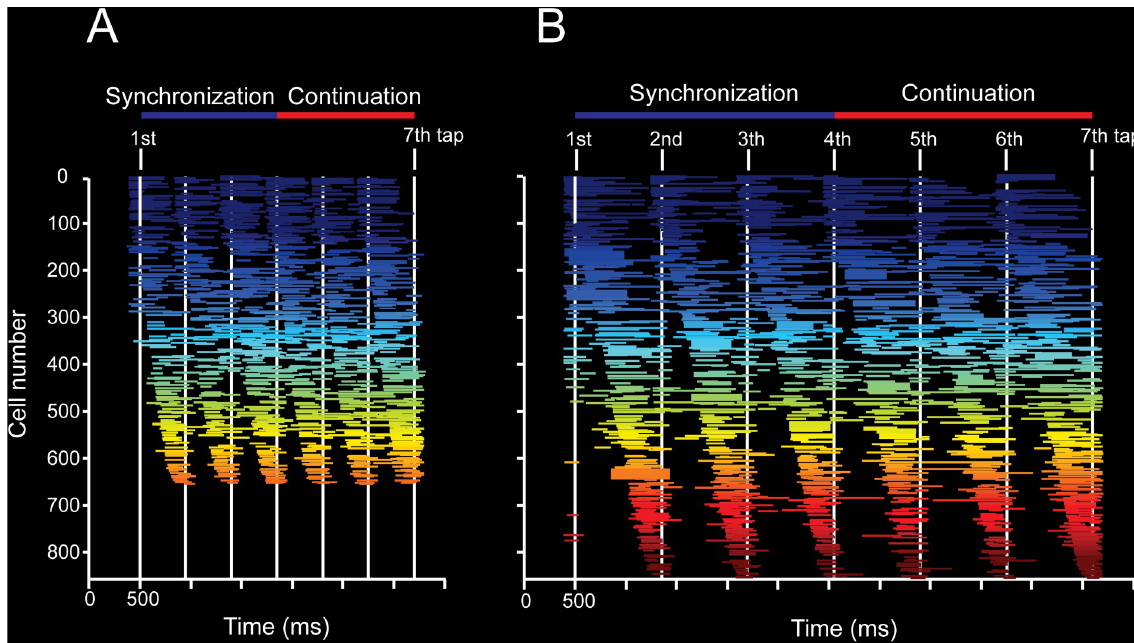
Fig 8. Overall patterns of activity in cell populations. A,B. Neural activation periods, sorted by their mean peak activation time, during the SCT task for the target intervals of 450 (A) and 850 (B) ms. Each horizontal line corresponds to the onset and duration of the significant activation period of a cell according to the Poisson-train analysis (see Materials and methods). The Poisson-train analysis was carried out on the discharge rate of cells that was warped in relation to the tapping times (seven white vertical lines [4,73]). Note that the number of cells with significant activation periods is larger for the longer target interval. Underlying data are available in https://doid.gin.g-node.org/ d315b3db0cee15869b3d9ed164f88cfa/. SCT, synchronization-continuation